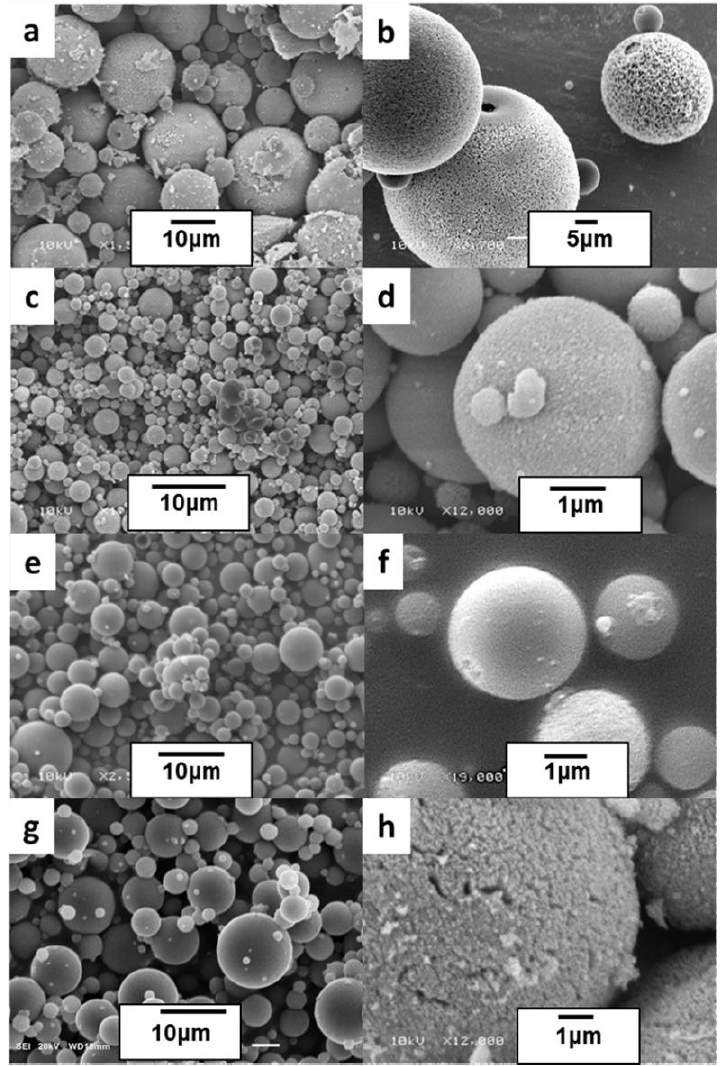
Figure 3. SEM images of SiC and SiC/C f microspheres representative for different DVB/PHMS w / w ratio: ( a , b ) (A-1) = 0.17, ( c , d ) (A-3) = 0.48, ( e , f ) (A-6) = 0.97, ( g , h ) (B-1) DVTMDS/PHMS = 0.22. Table 2. Characteristics of ceramic SiC and SiC/C f microspheres.